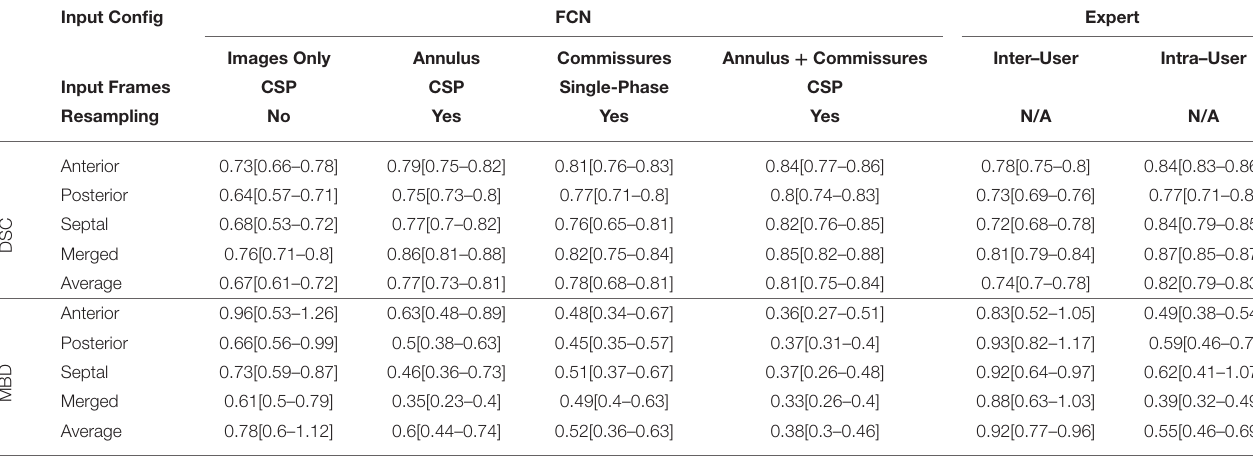
TABLE 5 | Comparison of the best ranked inference results across all stages of repair to expert